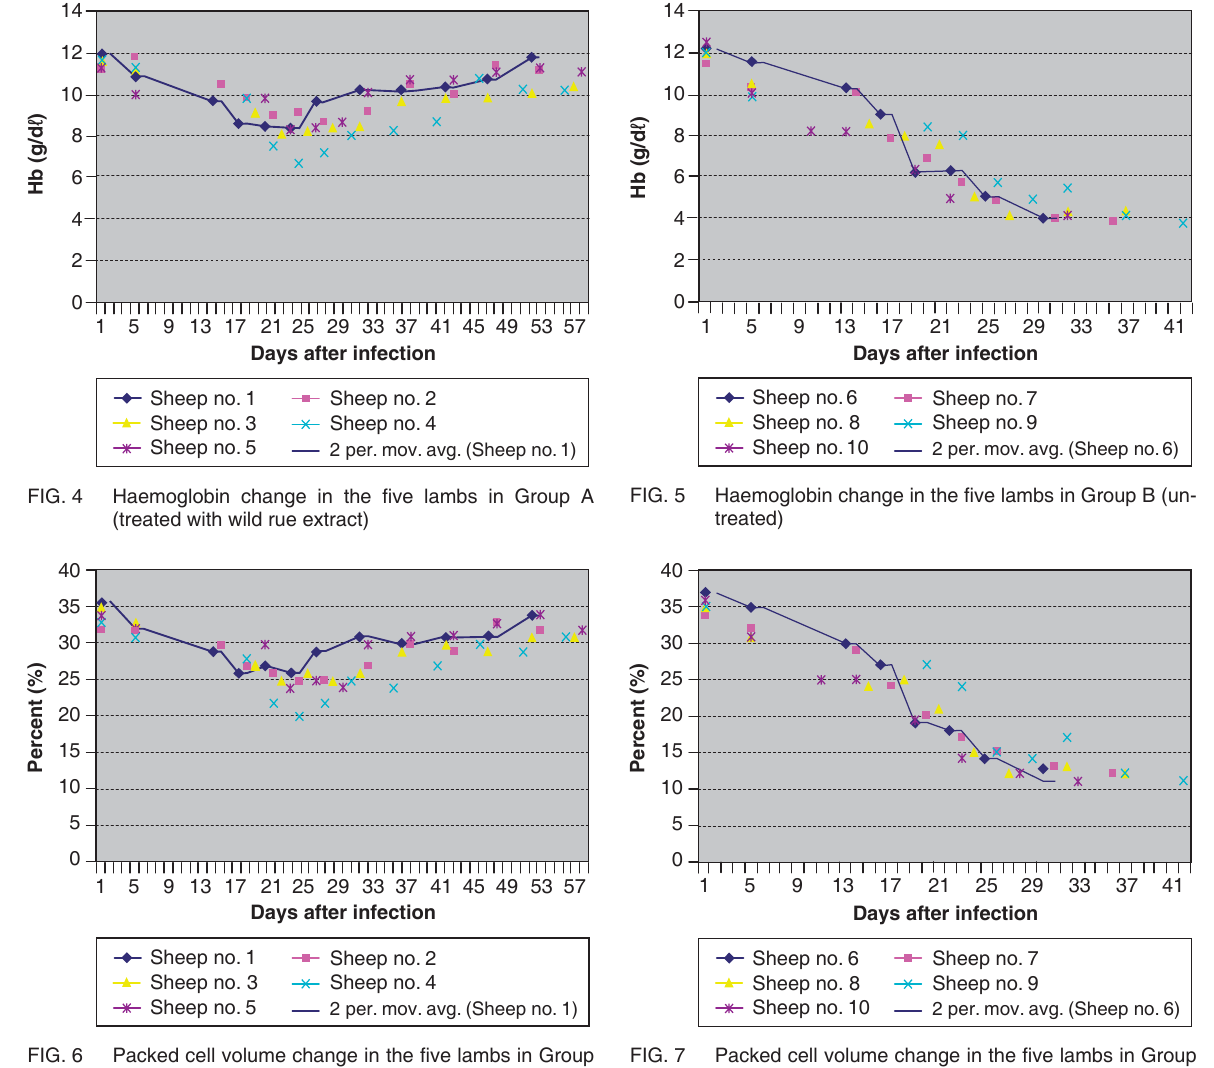
FIG. 4 Haemoglobin change in the five lambs in Group A (treated with wild rue extract)